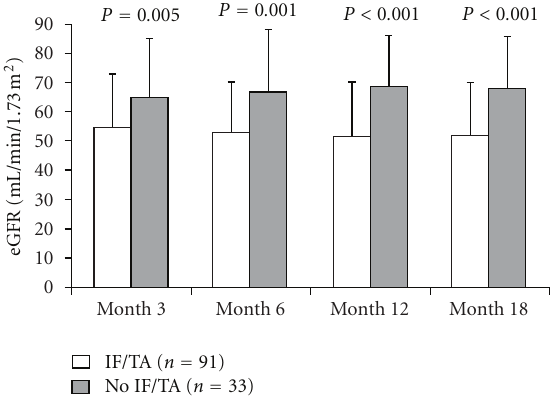
Figure 1: eGFR (aMDRD) according to the presence ( n = 91) or absence ( n = 33) of IF/TA detected on surveillance or diagnostic biopsy (mean ±